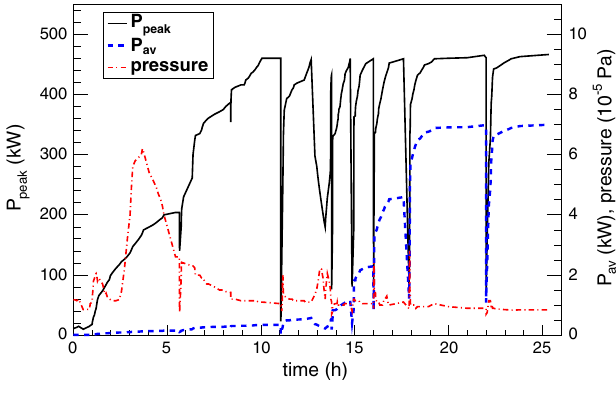
FIG. 4. Conditioning history of RFQ III.